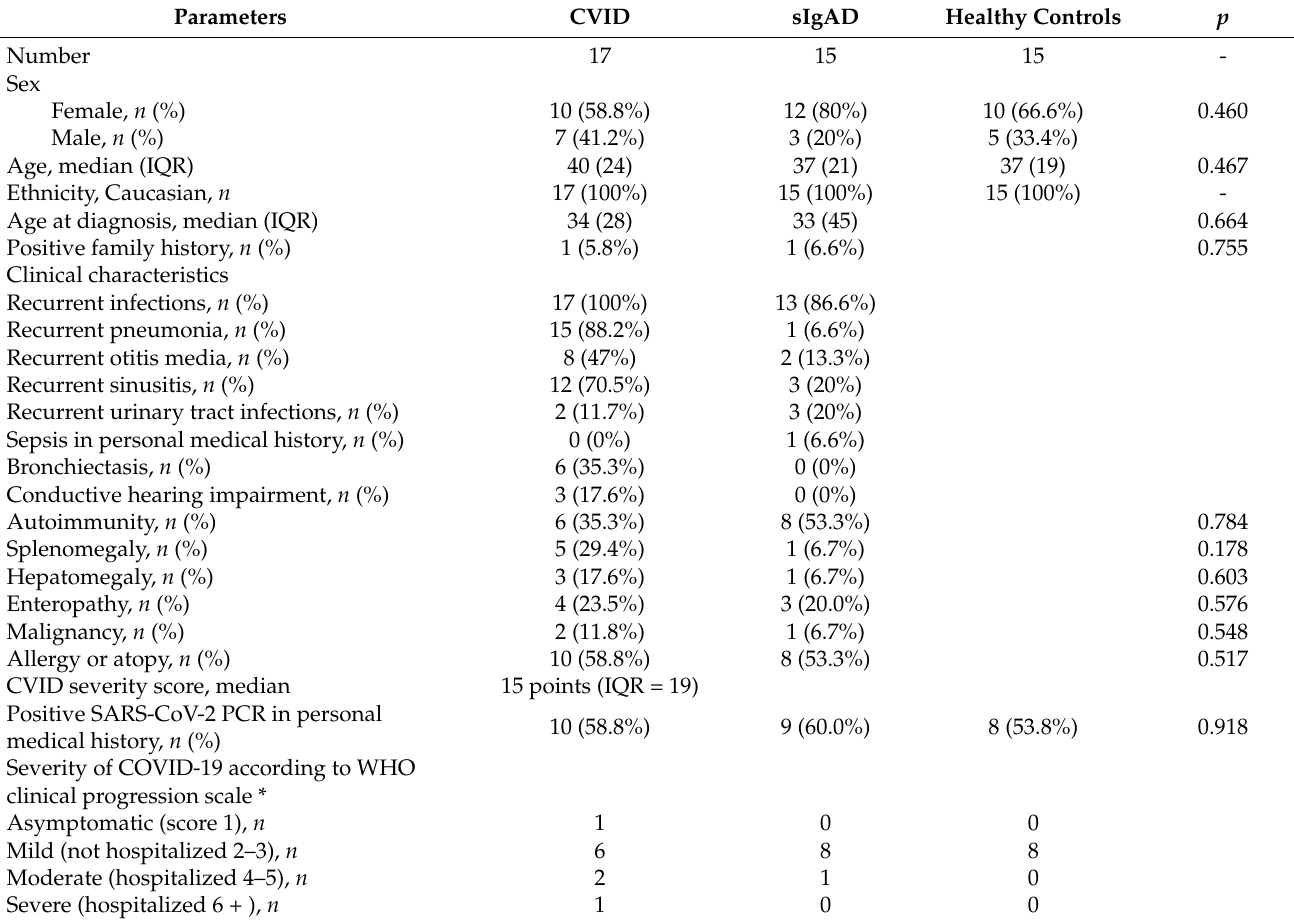
Table 1. Demographic and clinical parameters of the patients and